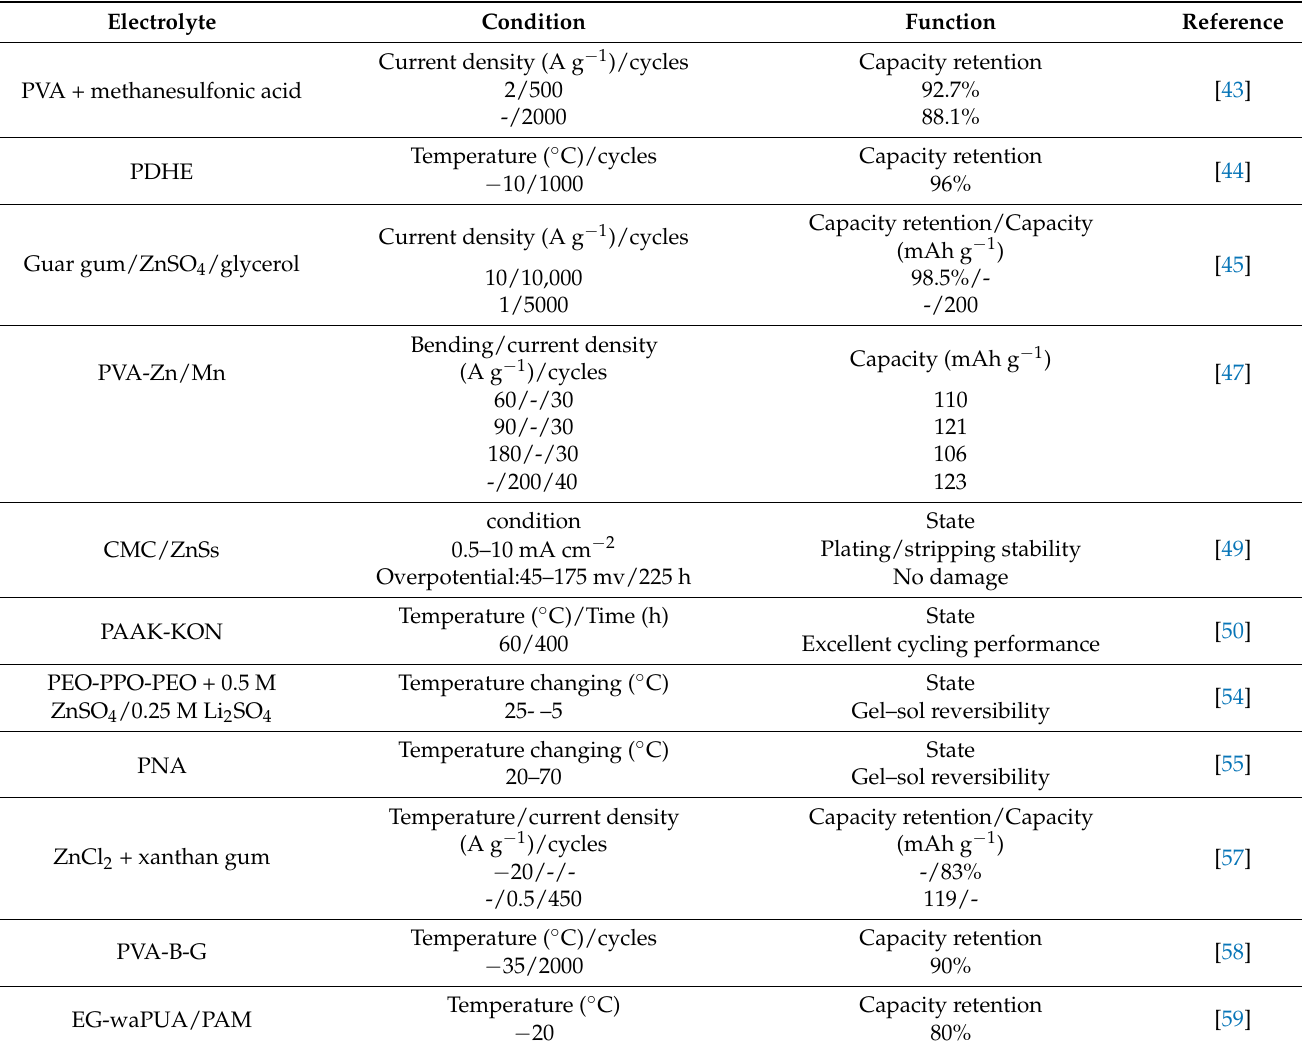
Table 1. The performance of ZINs by using diffident gel-state